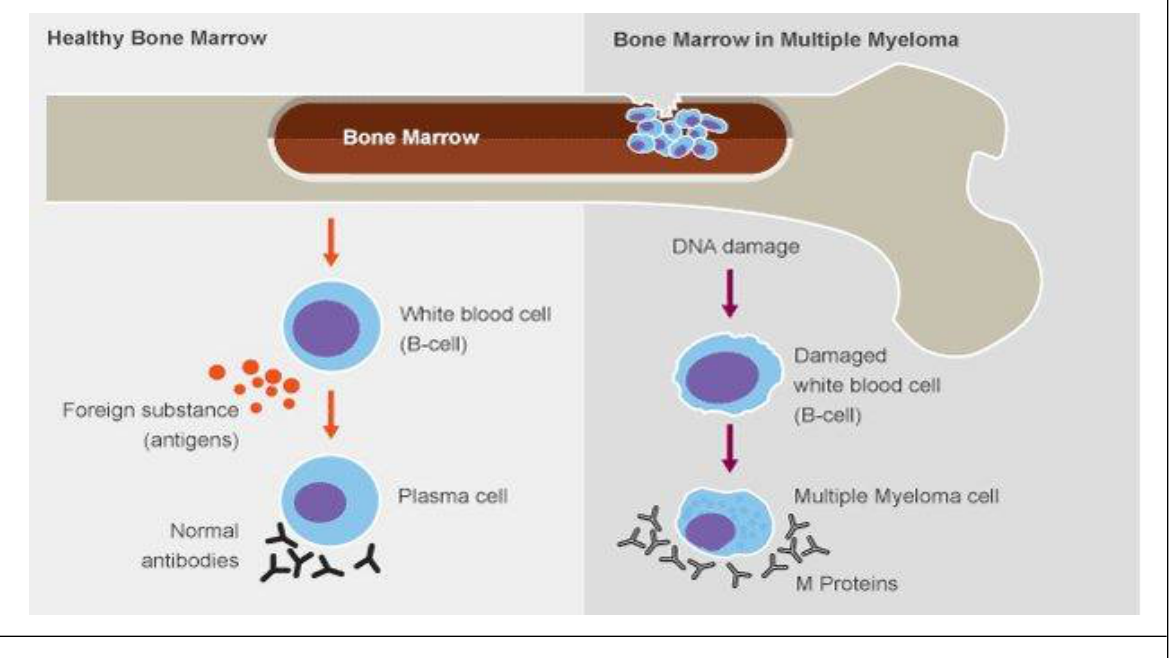
Figure 1: Schematic diagram of healthy bone marrow and bone marrow in case of multiple